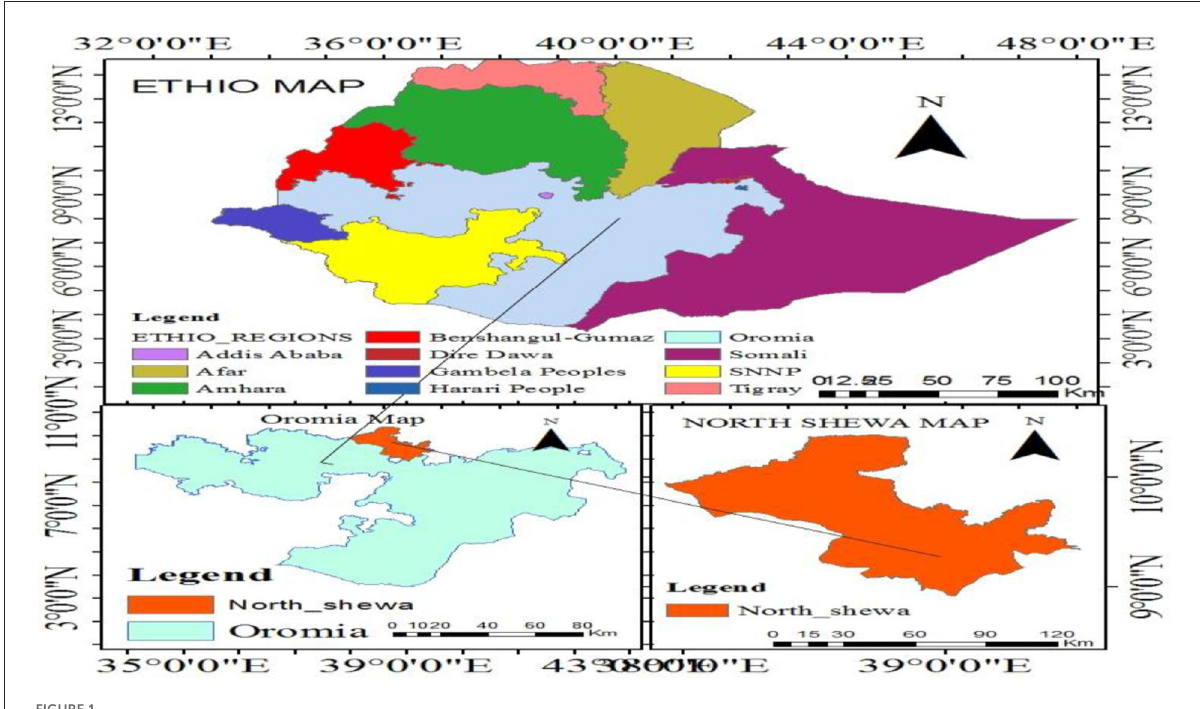
FIGURE1 Map of the study area, North Shewa zone, Central Ethiopia,